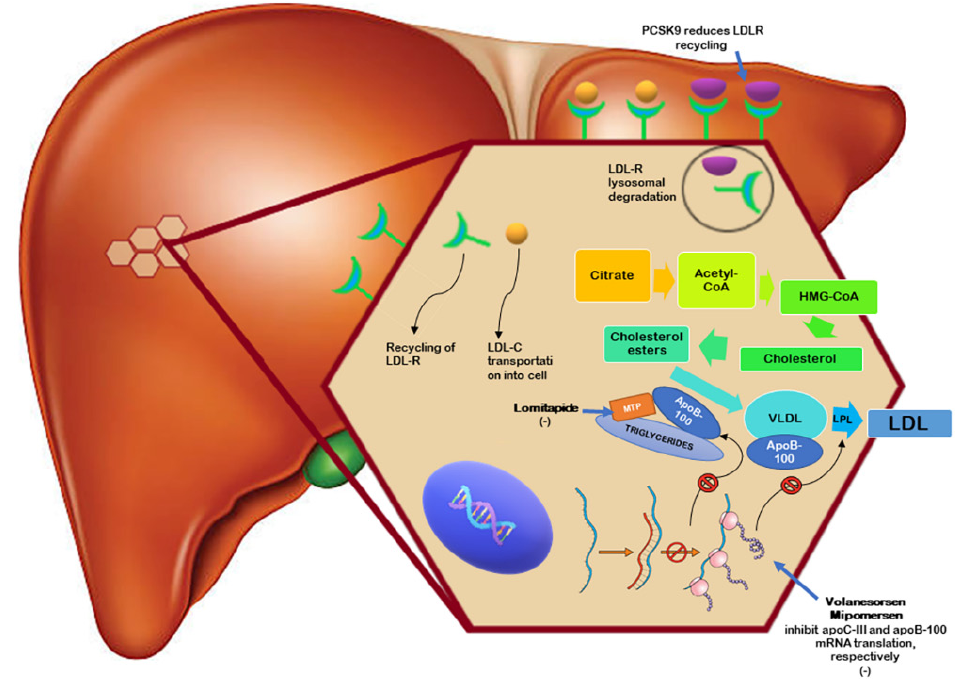
Figure 2. Mechanism of action of novel drugs used in patients with homozygous familial hypercholesterolemia (HoFH) .